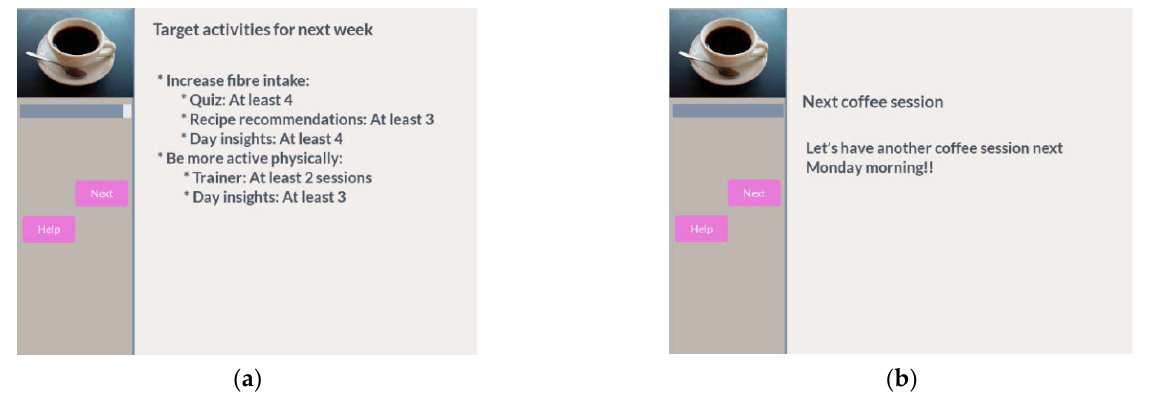
Figure 15. Preview target activities next week and reminder for next week. ( a ) See the target activities for next week; ( b ) reminder for next week’s coffee.